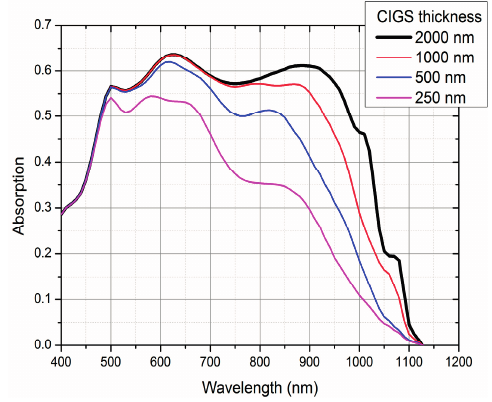
Figure 2. Absorption in the Cu(In,Ga)Se 2 (CIGS) absorber layer with the varying